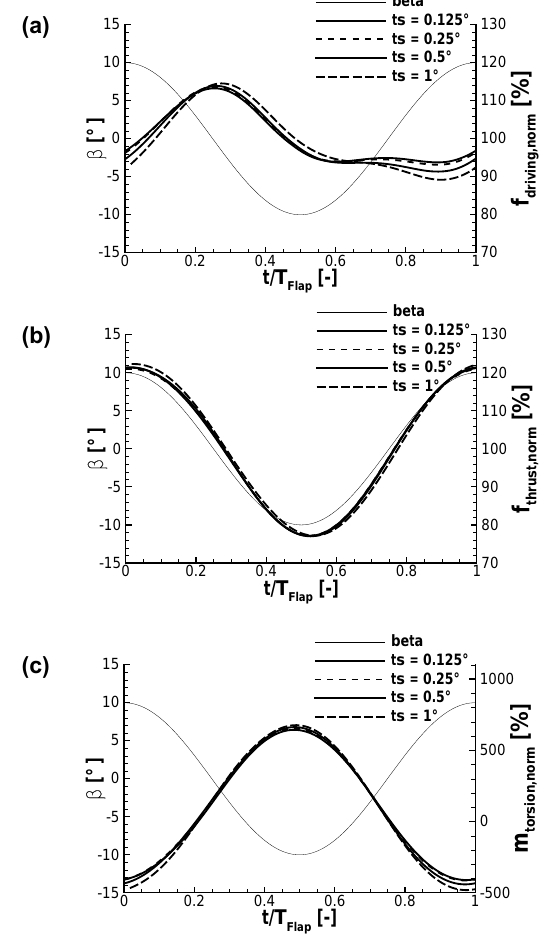
Figure 8. Influence of time step in 3-D, 6p, 75% blade cut (driving force, a ; thrust, b ; and local torsion moment, c ).